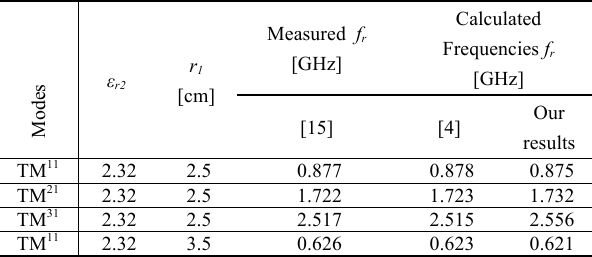
Table 1: Comparison of measured and theoretical resonant frequencies for no gap case, d